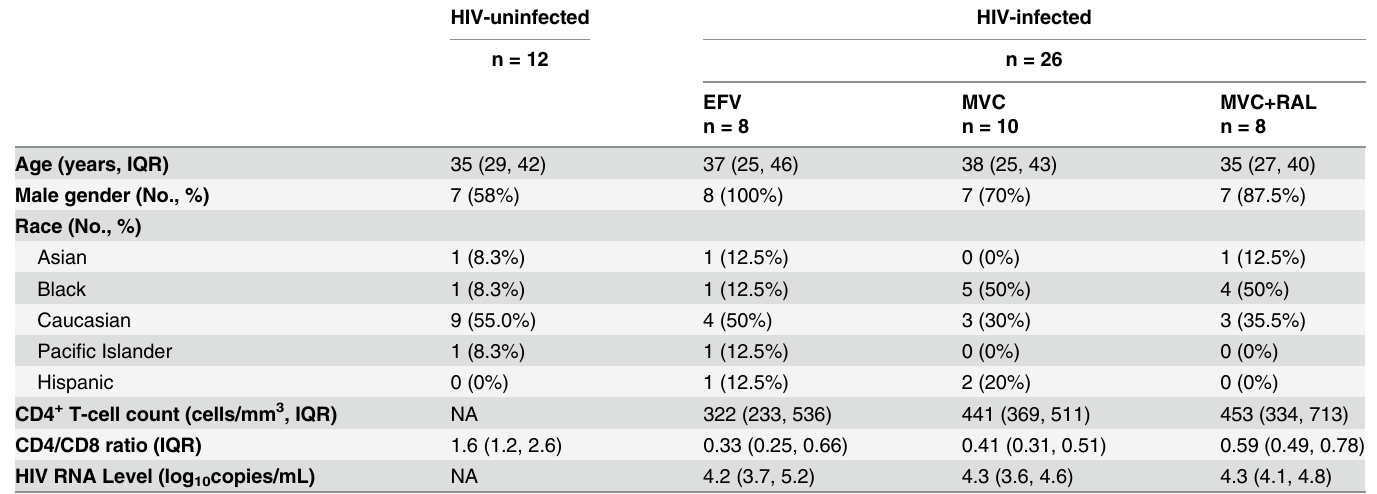
Table 1. General characteristics of study